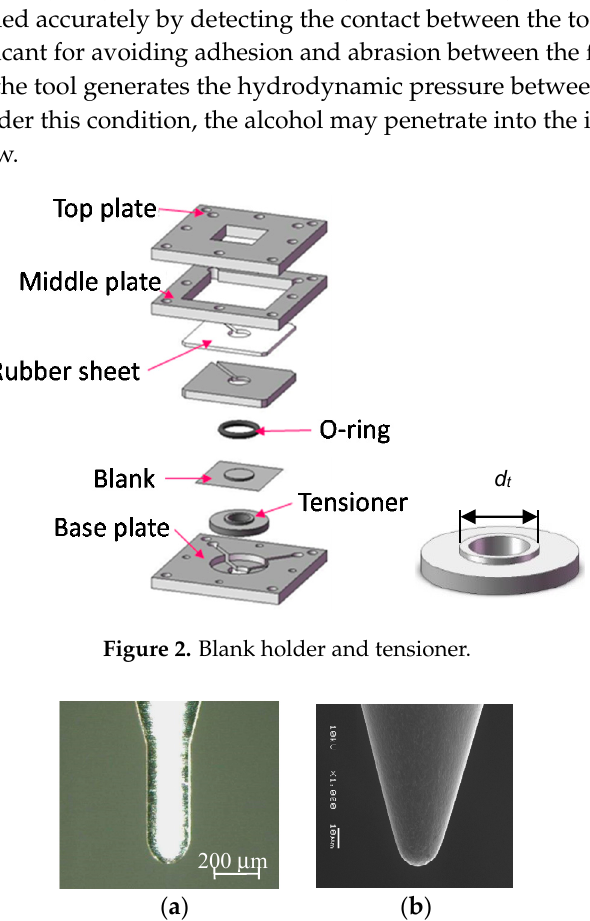
Figure 3. Microtool for incremental microforming: ( a ) R = 100 μ m; ( b ) R = 10 μ m.